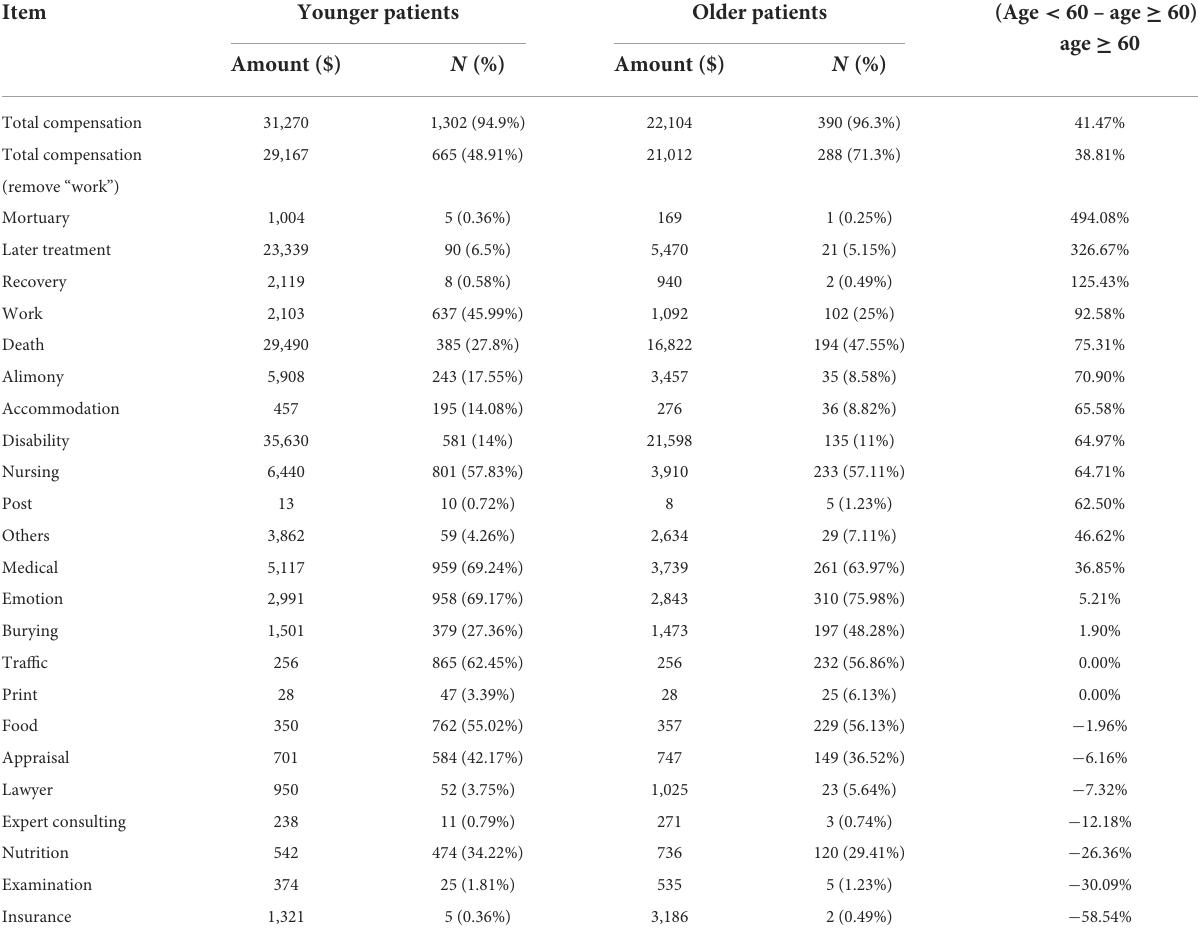
TABLE 2 Comparison of compensation between older and younger